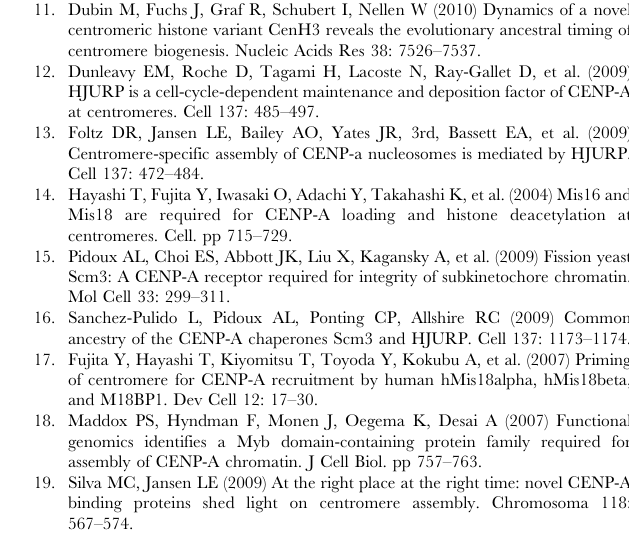
intensity values on Day 1 (red shading) and Day 2 (blue shading) shows that the average decrease in intensity agrees with the intensity distributions for individual cells. Arrows point to the mean TMR CENP-C intensity for Day 1 and Day 2. B) Distribution of TMR-CAL1 intensity values as described for (A). Figure S4 Mitotic loading of SNAP-CID. A) Images of BTP- blocked SNAP-CID cells. TMR is shown in red, total CID in green, phospho H3 in blue, and DAPI in grey. Bar= 15 m m. The efficiency of the blocking was consistently above 97%. B) FACS profiles showing the DNA content of S2 SNAP-CID cells from the quench-chase-pulse experiments in Figure 2. Samples for FACS were taken at 1, 2, 10, and 24 h following addition of BTP-block. The FACS profiles show that the distributions of cells in G1, S, and G2 are consistent between all time points. The approximate percentages of cells in each stage were estimated using FlowJo software (Tree Star, Inc.). C) Graphs showing the percent of cells containing new SNAP-CID (y-axis) in interphase versus mitosis at 1, 2, 10, 24 h. Bars indicate standard error. *** p , 0.0001 (Fisher’s exact test; n . 100 cells per time-point). Figure S5 New CID recruitment in SNAP-Kc167 cells. CID is recruited in mitosis in the independent Drosophila cell type, Kc167. Percent of interphase and mitotic cells showing new SNAP-CID recruitment at 0, 1, 2, 10, and 24 h following BTP- block in clonal SNAP-CID Kc167 cells. New CID recruitment is visible within the first hour following BTP-block and incorporation occurs preferentially in mitotic cells ( . 50% of mitotic cells are TMR-CID positive at 1 h). Bars indicate standard error.